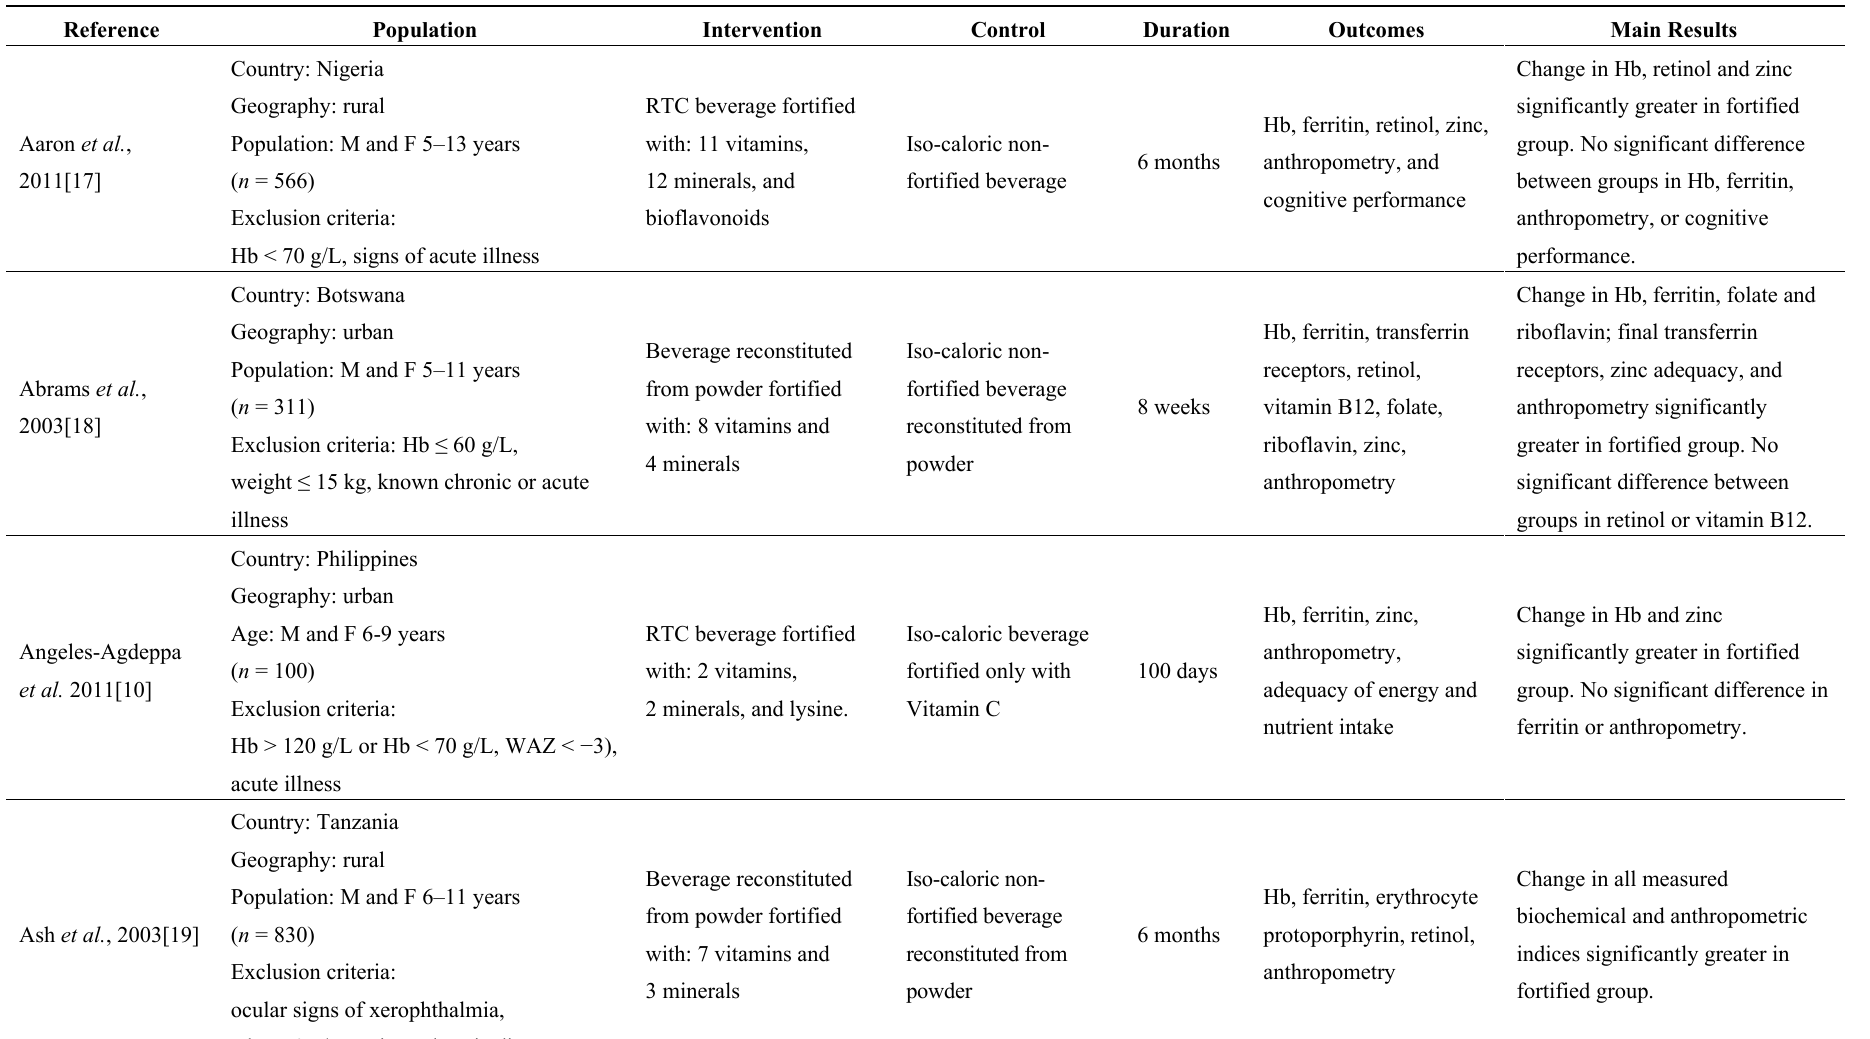
Table 2. Study descriptions and main results for studies included in the